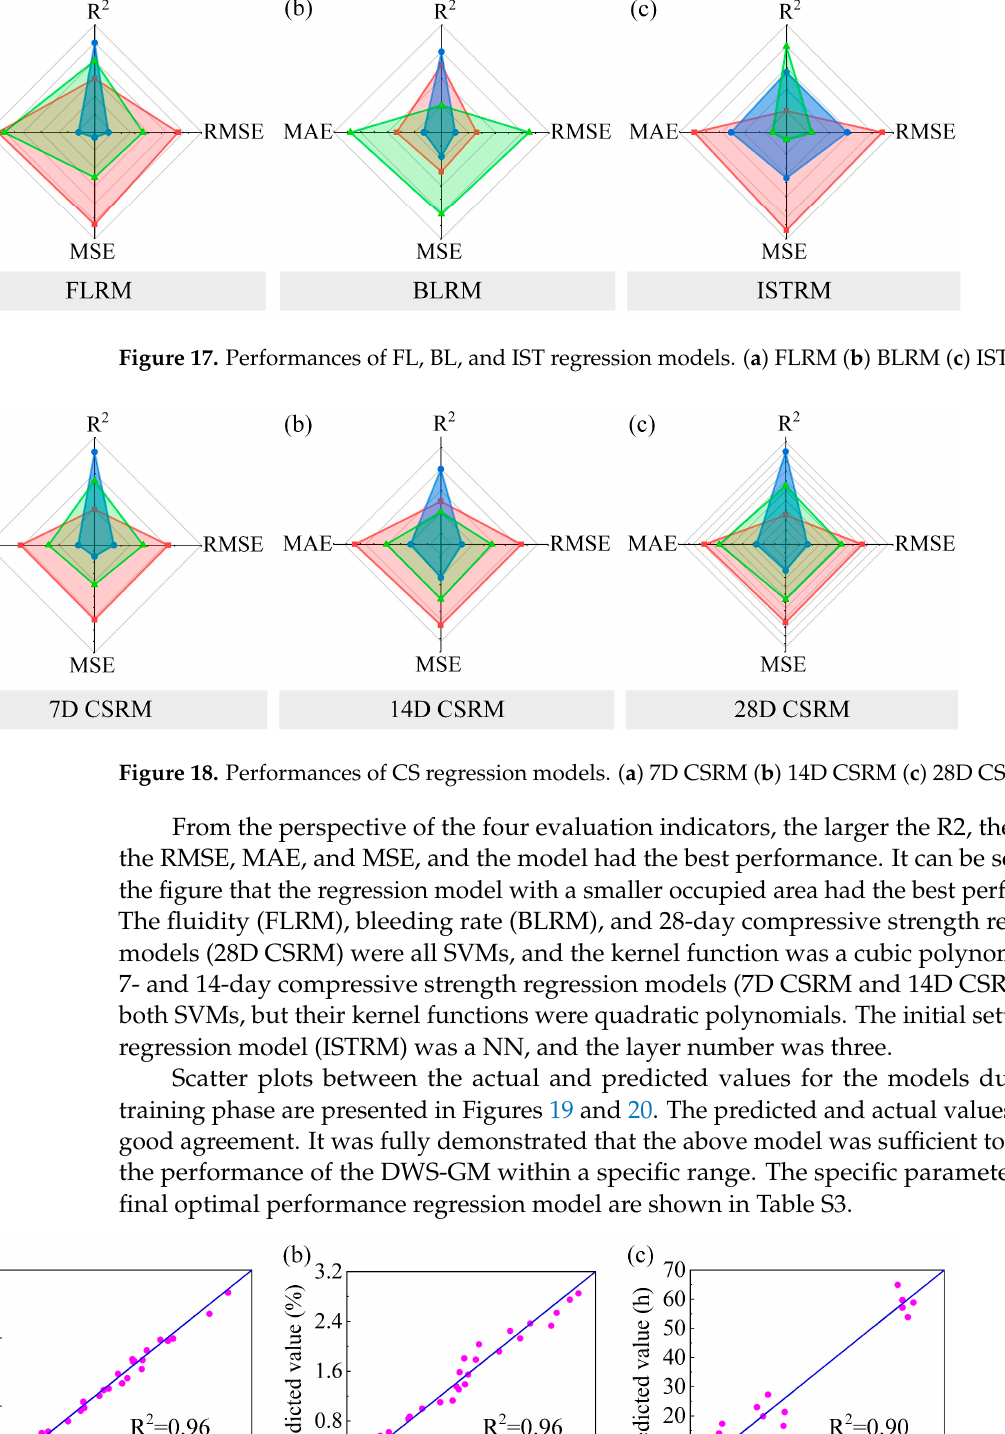
Figure 20. Performances of CS predicted models. ( a ) 7D ( b ) 14D ( c ) 28D. Figure 19. Performances of FL, BL, and IST predicted models. ( a ) FL ( b ) BL ( c ) IST.